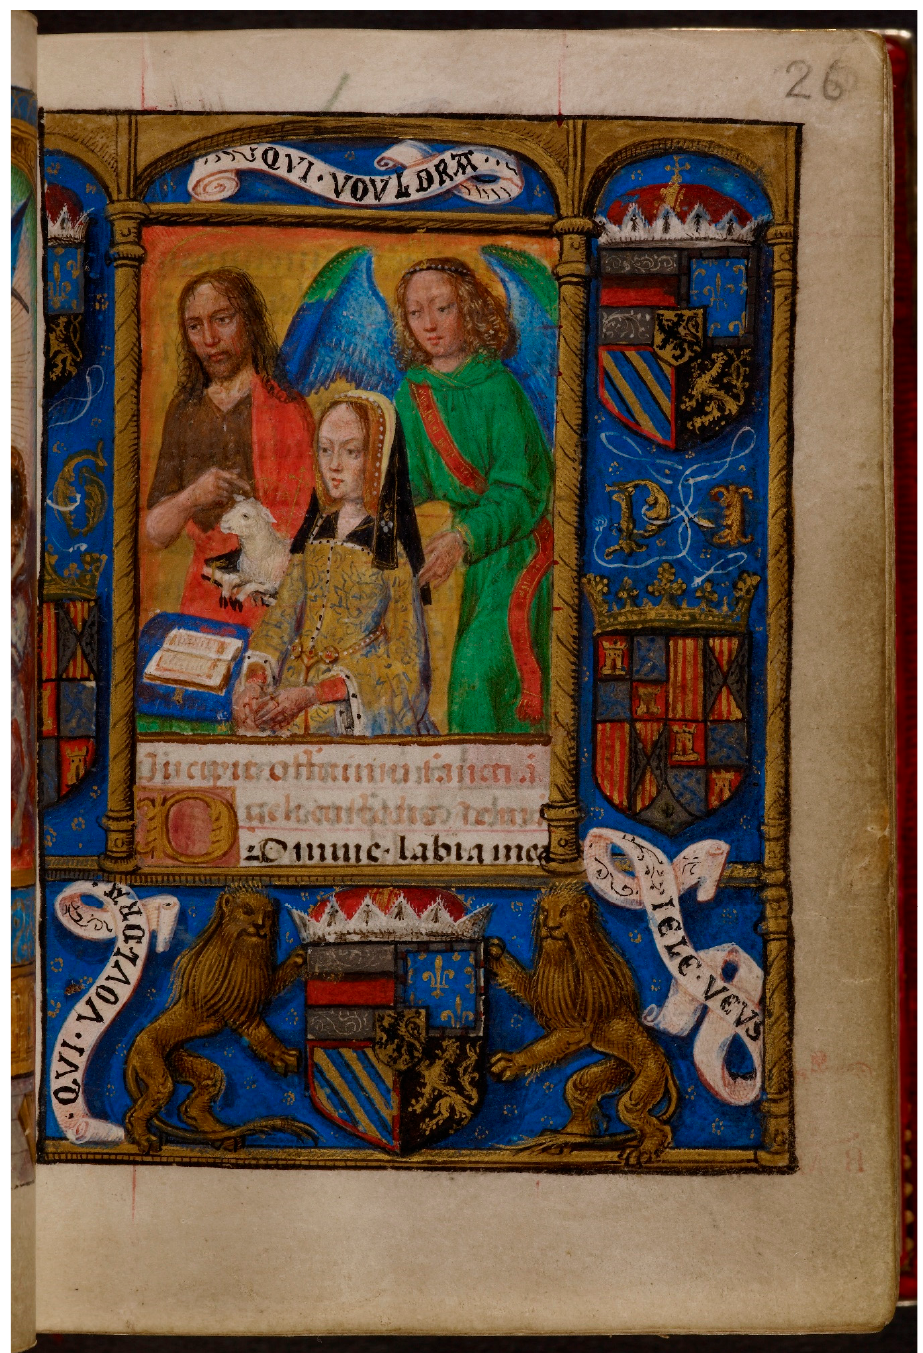
Figure 1. London, British Library, Add. MS 18852, fol. 26r. Hours of the Guardian Angel. Tracing Juana’s prayer in this book, more than any other, gives an insight into her life as a young wife, rather than the disastrous later years of her semi-incarceration in Castile. The gifted hours were